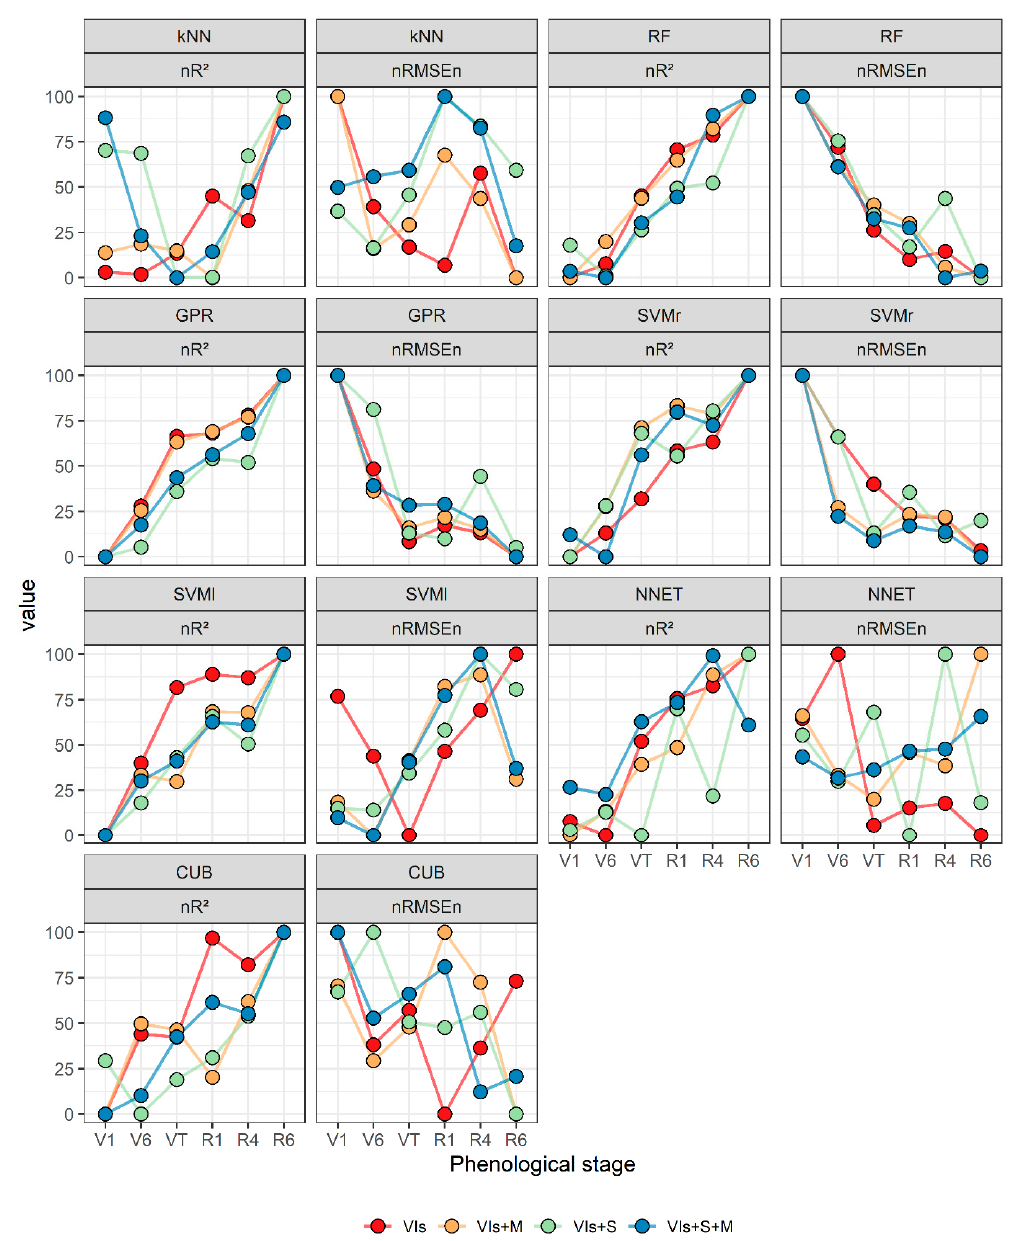
Figure 4. Normalized values of R 2 and nRMSE (nR 2 and nRMSEn) at six phenological stages for four feature sets (VIs, VIs + M, VIs + S, VIs + S + M) using the seven ML algorithms (kNN, SVMr, RF, CUB, GPR, SVMl, and NNET) .